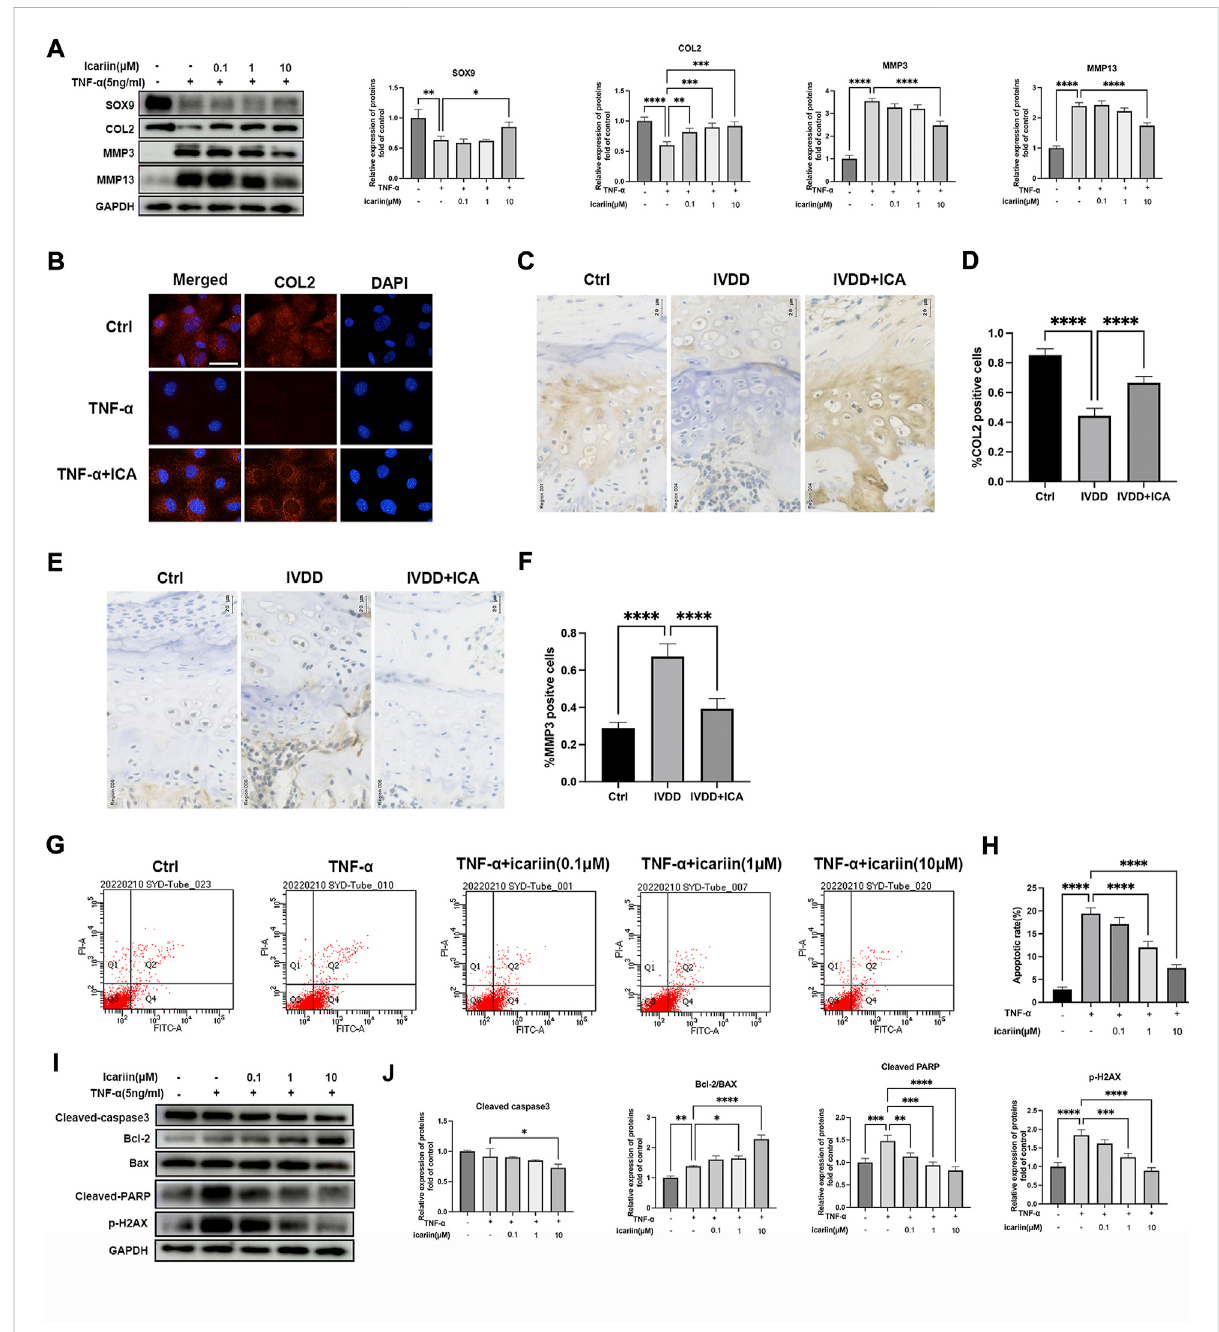
FIGURE 2 ICA suppressed TNF- α induced chondrocytes apoptosis and CEP degeneration. (A) Chondrocytes were treated with TNF- α (5 ng/ml) and ICA (0.1, 1, and 10 μ M) for 24 h, and Western blot was conducted to examine the protein levels of COL2, SOX9, MMP3, and MMP13. The band density of COL2, SOX9, MMP3, and MMP13wasquanti fi edand normalized to control. (B) Chondrocytes weretreated with TNF- α (5 ng/ml)with or without ICA (10 μ M) for 24 h, and immuno fl uorescence staining was conducted to examine the expression of COL2 (red). Scale bar = 20 µm. (C,E) Immunohistochemistry for COL2 and MMP3 in the Ctrl, IVDD, and IVDD + ICA groups. Scale bar = 20 μ M. (D,F) The ratio of positive cells for COL2andMMP3inendplateoftheCtrl,IVDD,andIVDD+ICAgroups. (G,H) Chondrocytes weretreatedwithTNF- α (5 ng/ml)andICA(0.1,1,10 μ M) for 24 h, and annexin V-FITC/PI fl ow cytometric analysis was conducted to measure endplate chondrocyte apoptosis. Annexin V + /PI − cells were considered as apoptotic cells in the early phase and annexin V + /PI + cells were considered as apoptotic cells in the late phase. (I – J) Chondrocytes were treated with TNF- α (5 ng/ml) and ICA (0.1, 1, and 10 μ M) for 24 h, and Western blot was conducted to examine the protein levels of cleaved- caspase-3(CC3), Bax, Bcl-2, cleaved-PARP, and pSer139-H2AX. The band density was quanti fi ed and normalized to control. All experiments were repeated three times independently. Data are presented as mean ± SD. p p < 0.05, pp p < 0.01, ppp p < 0.001, and pppp p <